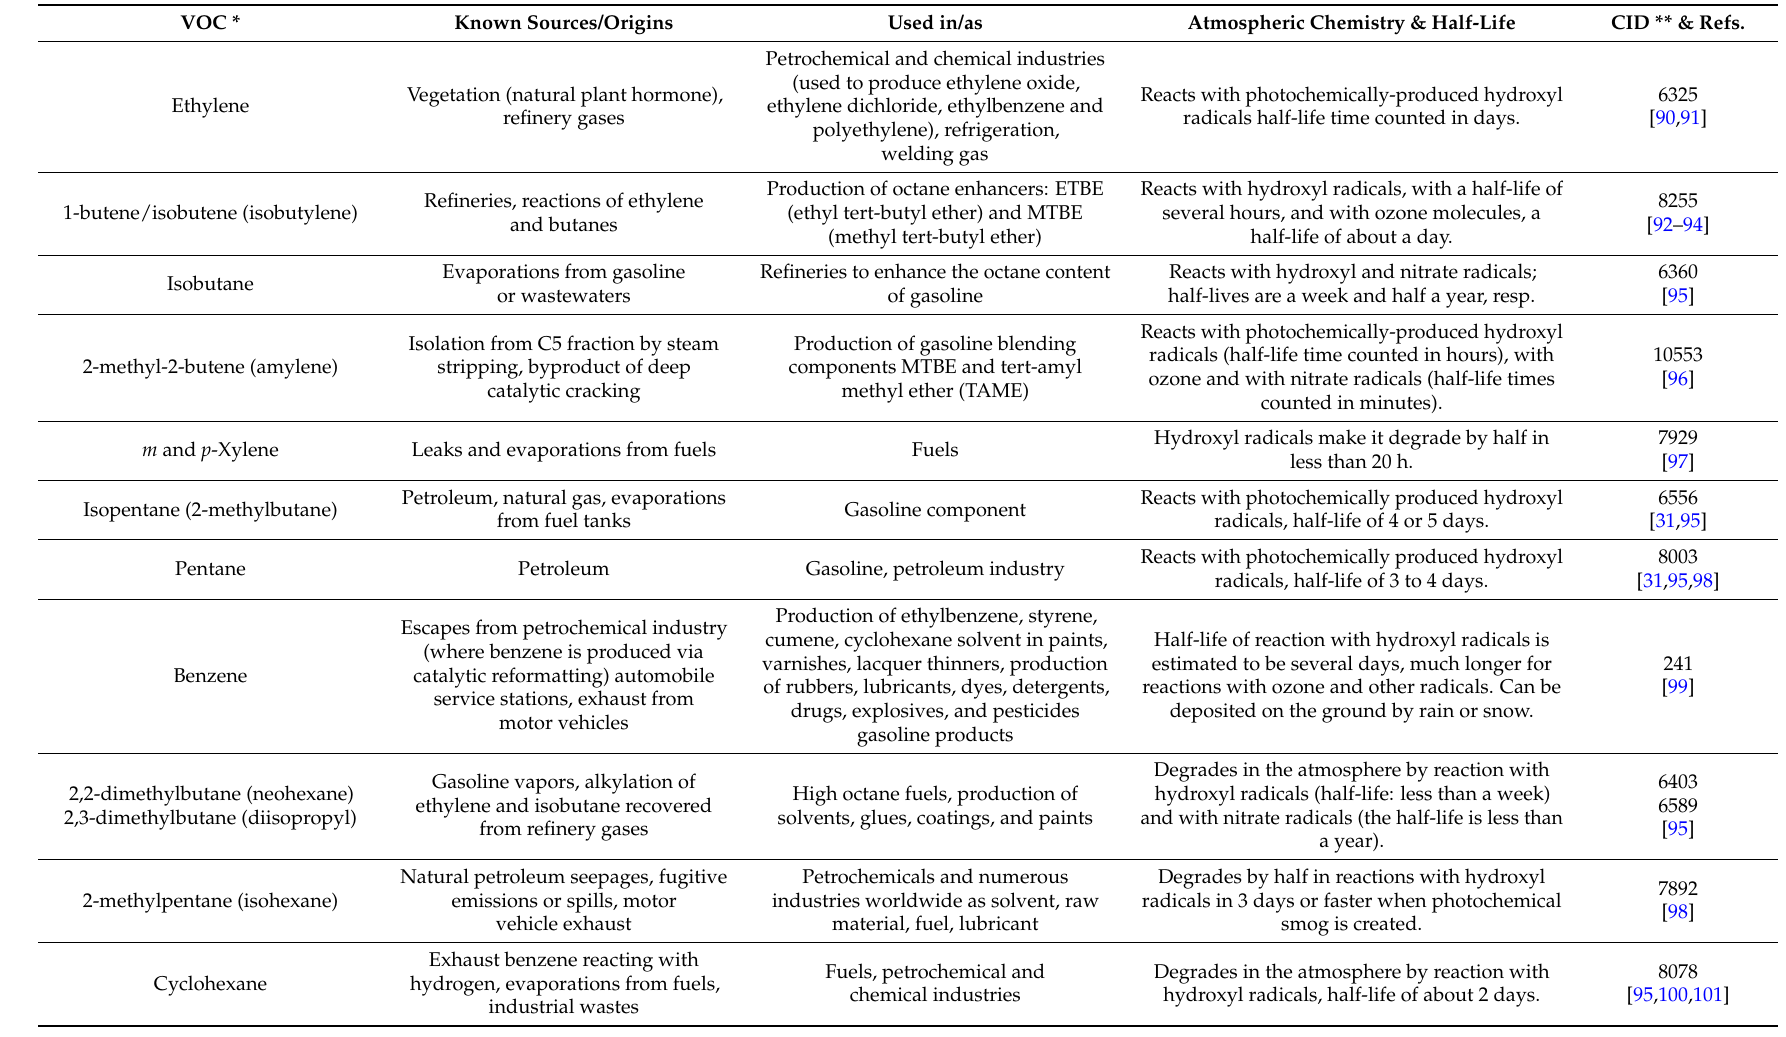
Table 1. Alkanes and alkenes appearing in the “evaporative” and “exhaust”